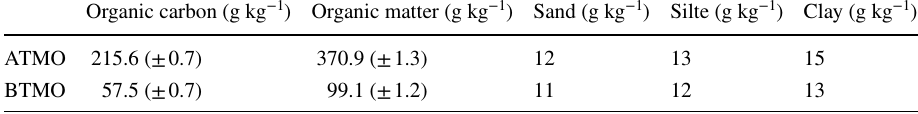
ATMO high content of organic matter, BTMO low organic matter